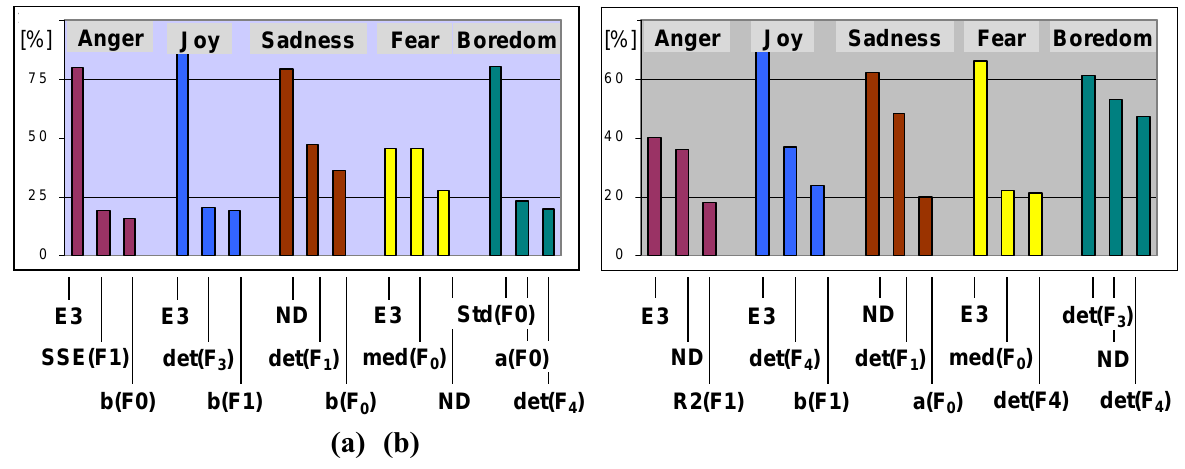
Figure 7. Best-performing features among triplets (a) and quadruples (b) in extracting particular emotions for German database, speaker-independent experiment.